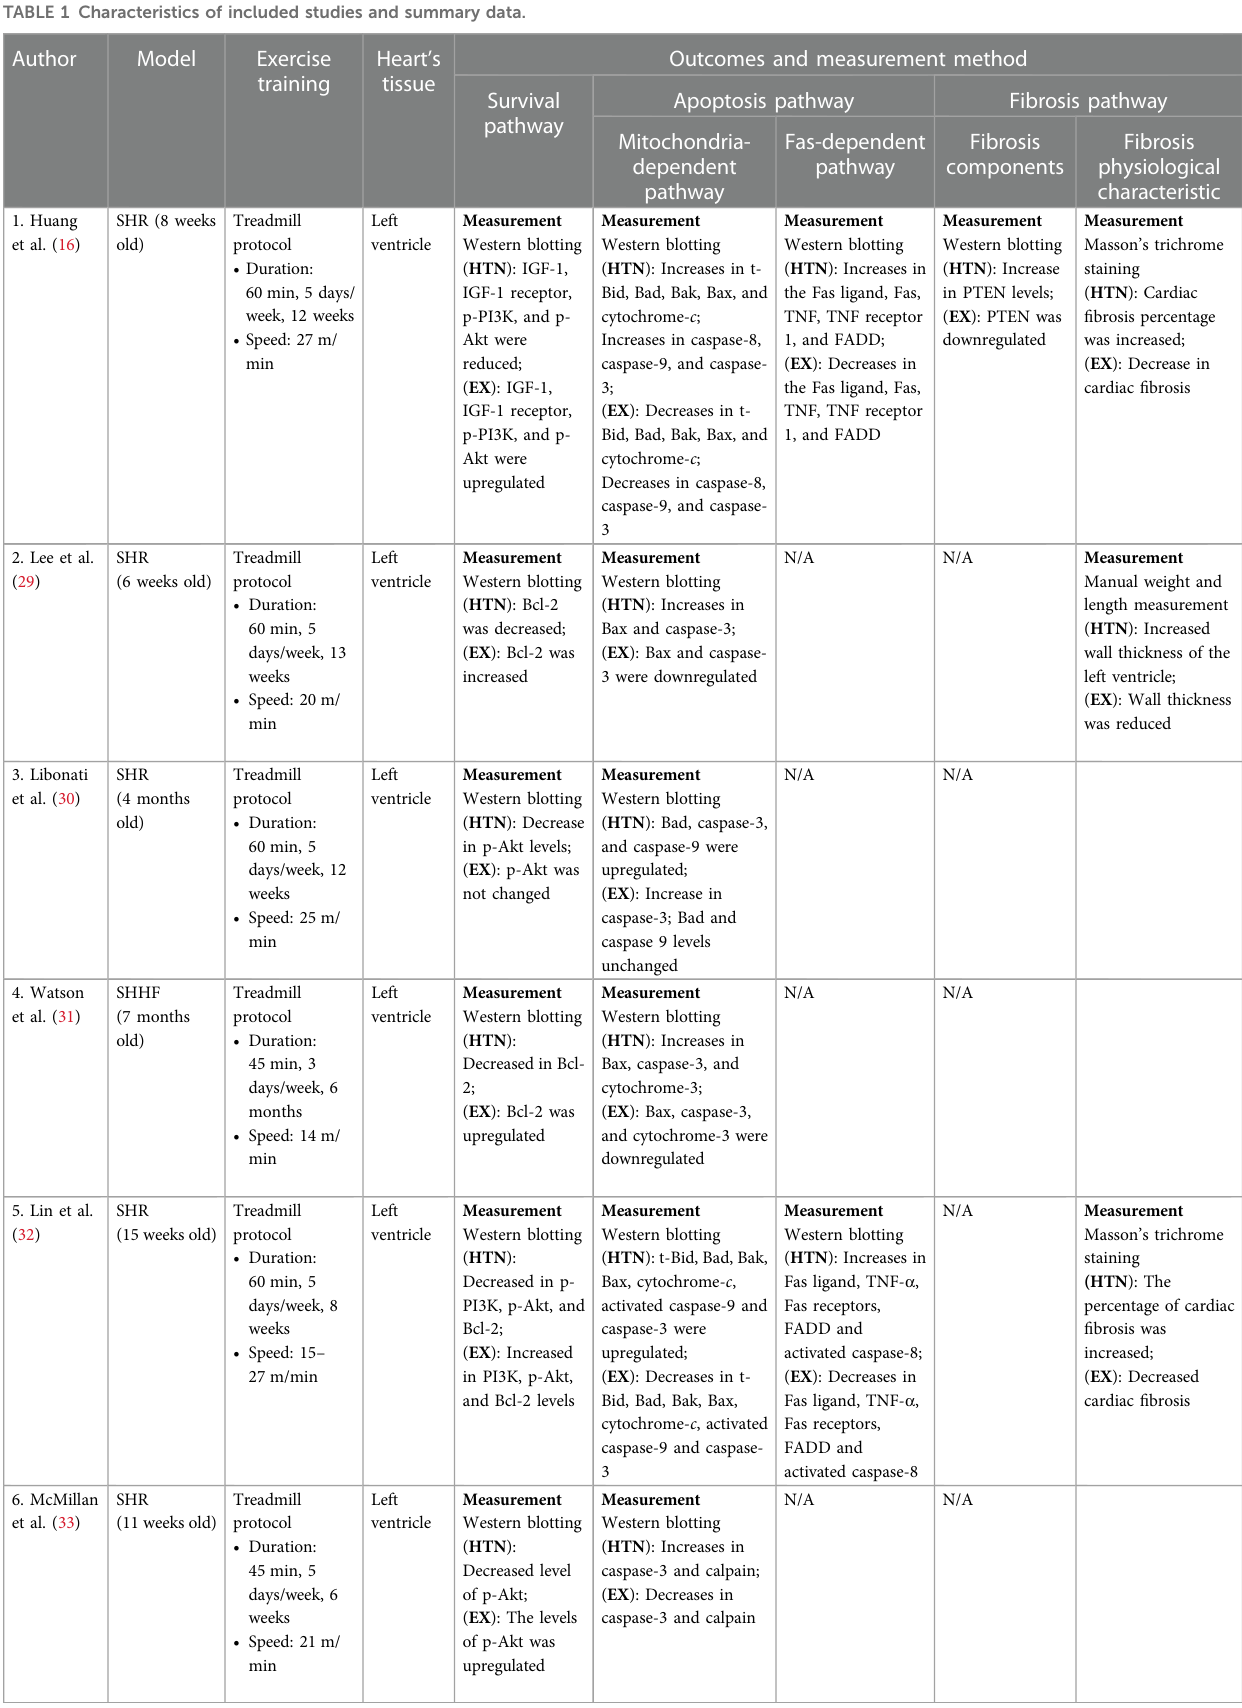
TABLE 1 Characteristics of included studies and summary